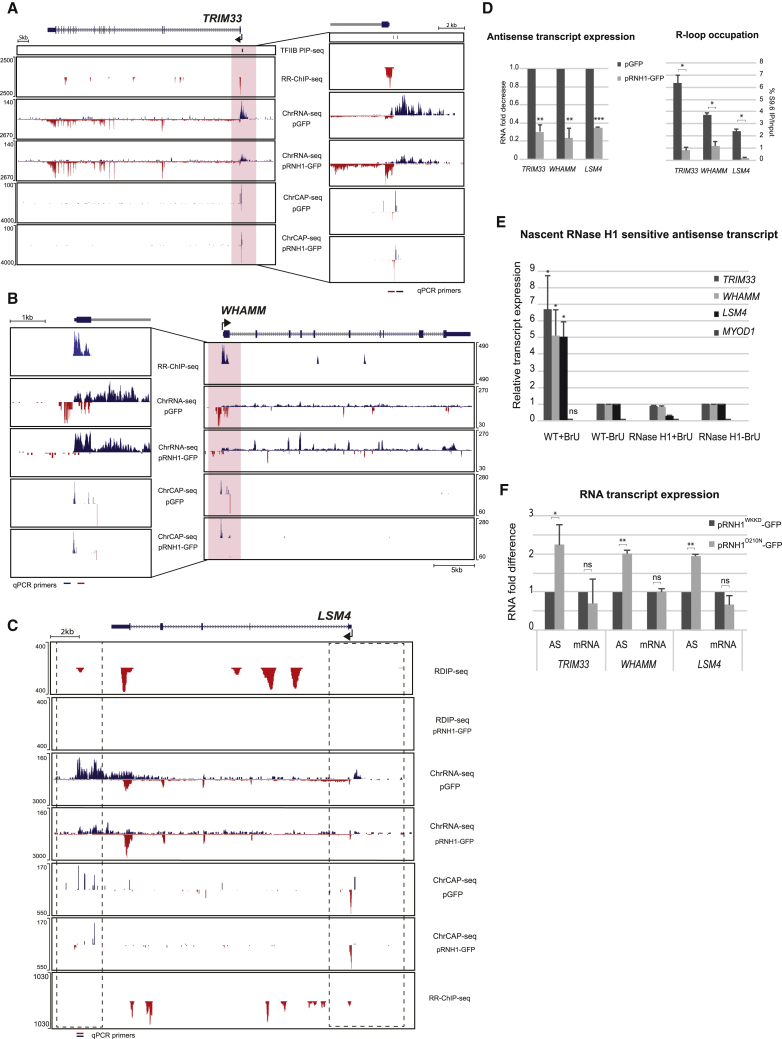
Validation of In Vivo R-Loop Promoter Activity(A–C) Comparisons of different R-loop and RNA profiles (RPM) for TRIM33 (A), WHAMM (B), and LSM4 (C) displaying RNase H1 capped sensitive AS lncRNA. Promoter regions for TRIM33 and WHAMM (pink shading) shown in expanded view.(D) Validation of AS lncRNA RNase H1 sensitivity by qRT-PCR with relative expression values normalized to 18S RNA (left). DIP analyses (Skourti-Stathaki et al., 2014) validate R-loop-occupied regions (right). Data are represented as mean ± SEM (n = 3; ∗p < 0.05, ∗∗p < 0.01, and ∗∗∗p < 0.001, paired t test). qPCR primer locations are indicated (A–C) as red horizontal bars for R-loop location and blue for AS transcript expression.(E) Bromo-UTP labeled nuclear run-on analysis of TSS R-loop promoter activity. Data are represented as mean ± SEM (n = 3; ∗p < 0.05, ∗∗p < 0.01, and ∗∗∗p < 0.001, between WT+BrU and RNaseH1+BrU, paired t test).(F) Quantification of S or AS transcripts by qRT-PCR, stabilizing R-loops with catalytic mutant pRNH1D210N-GFP. Data are represented as mean ± SEM (n = 3; ∗p < 0.05, ∗∗p < 0.01, and ∗∗∗p < 0.001, paired t test).